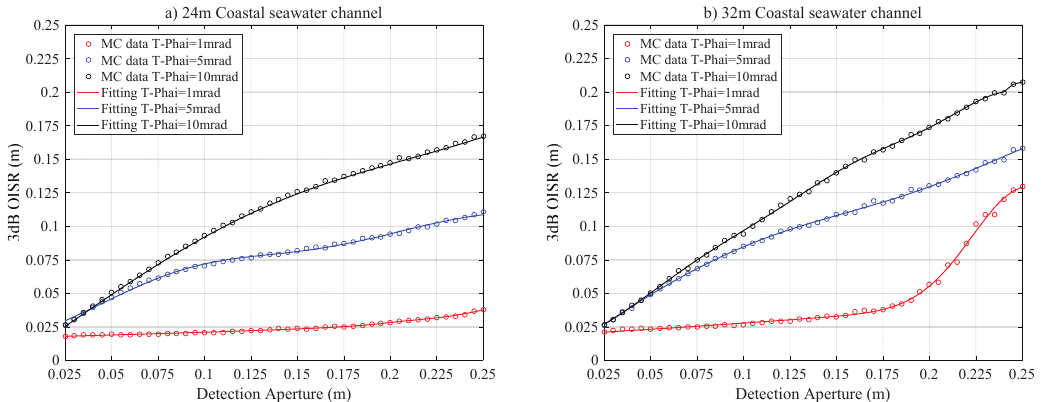
Figure 9. The r 3 dB versus R PD for the coastal seawater laser channel for a link distance of ( a ) 24 m and ( b ) 32 m.